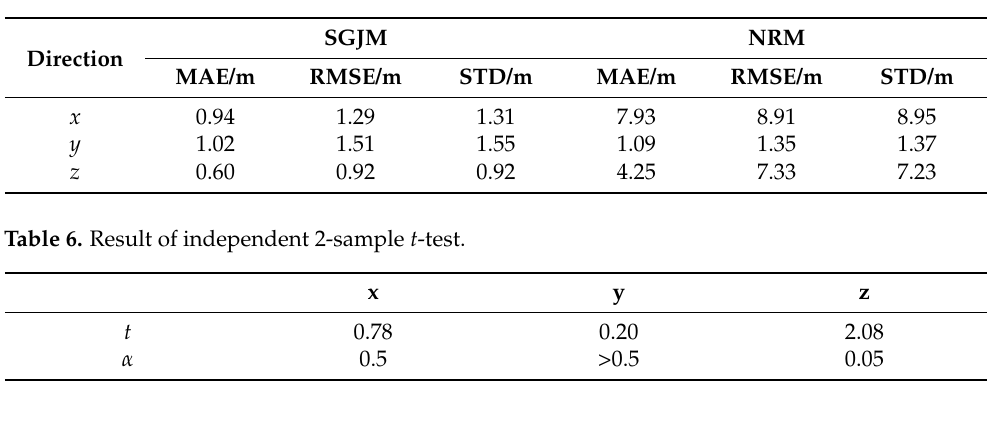
Table 5. MAE and RMSE with different methods.